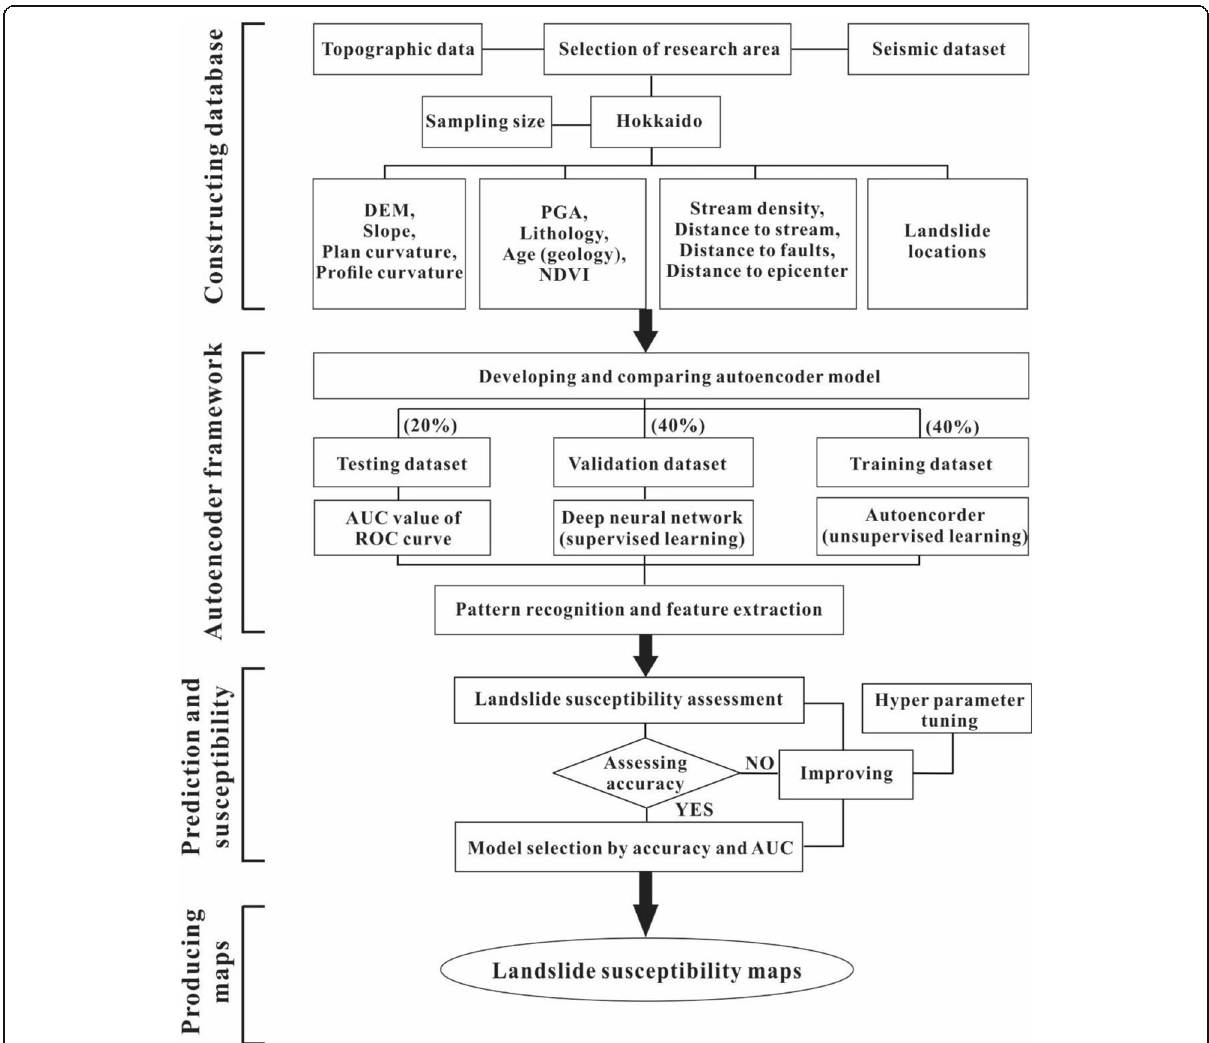
Fig. 3 Flow chart of the research